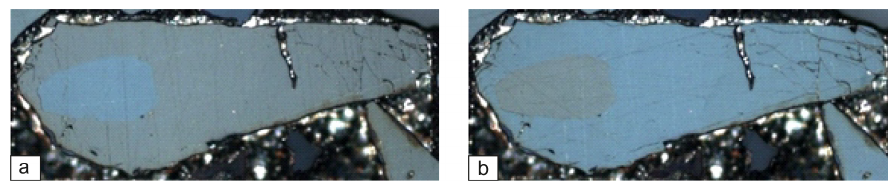
Figure 6. Pyrite grain under reflected and nearly cross-polarized light positioned at 0 ◦ (a) and rotated by 90 ◦ (b)